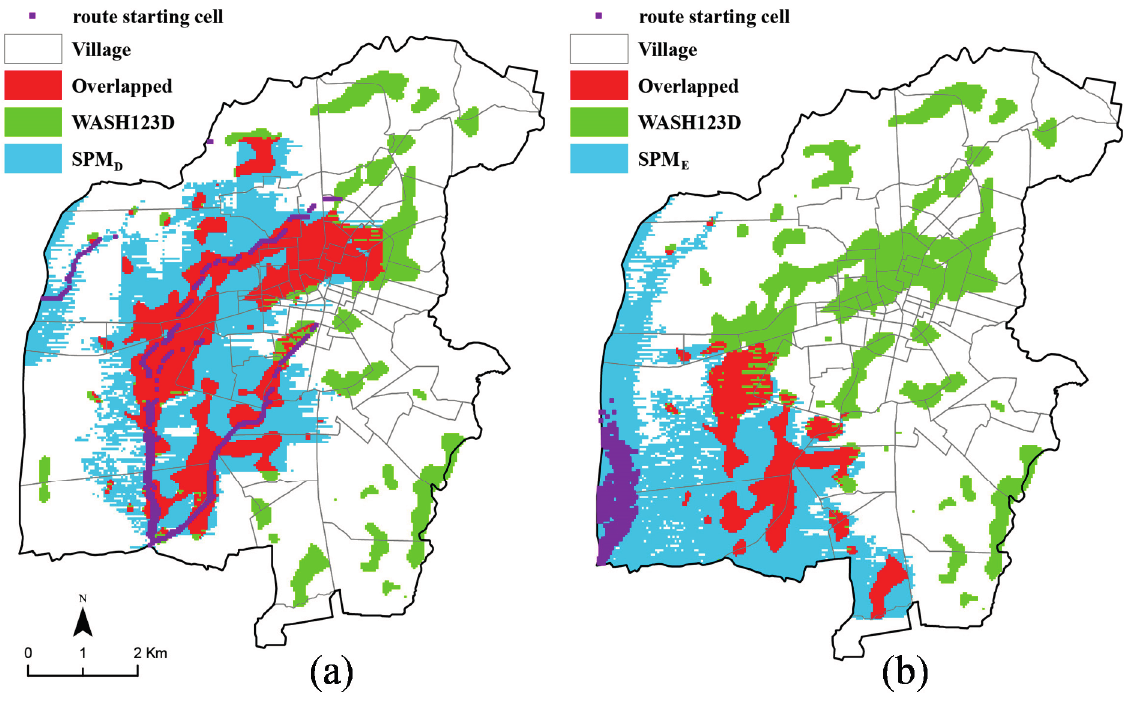
Figure 6. Overlapping flood areas at the grid level between WASH123D and SPM D ( a ) and SPM E ( b ) in Pingtung.